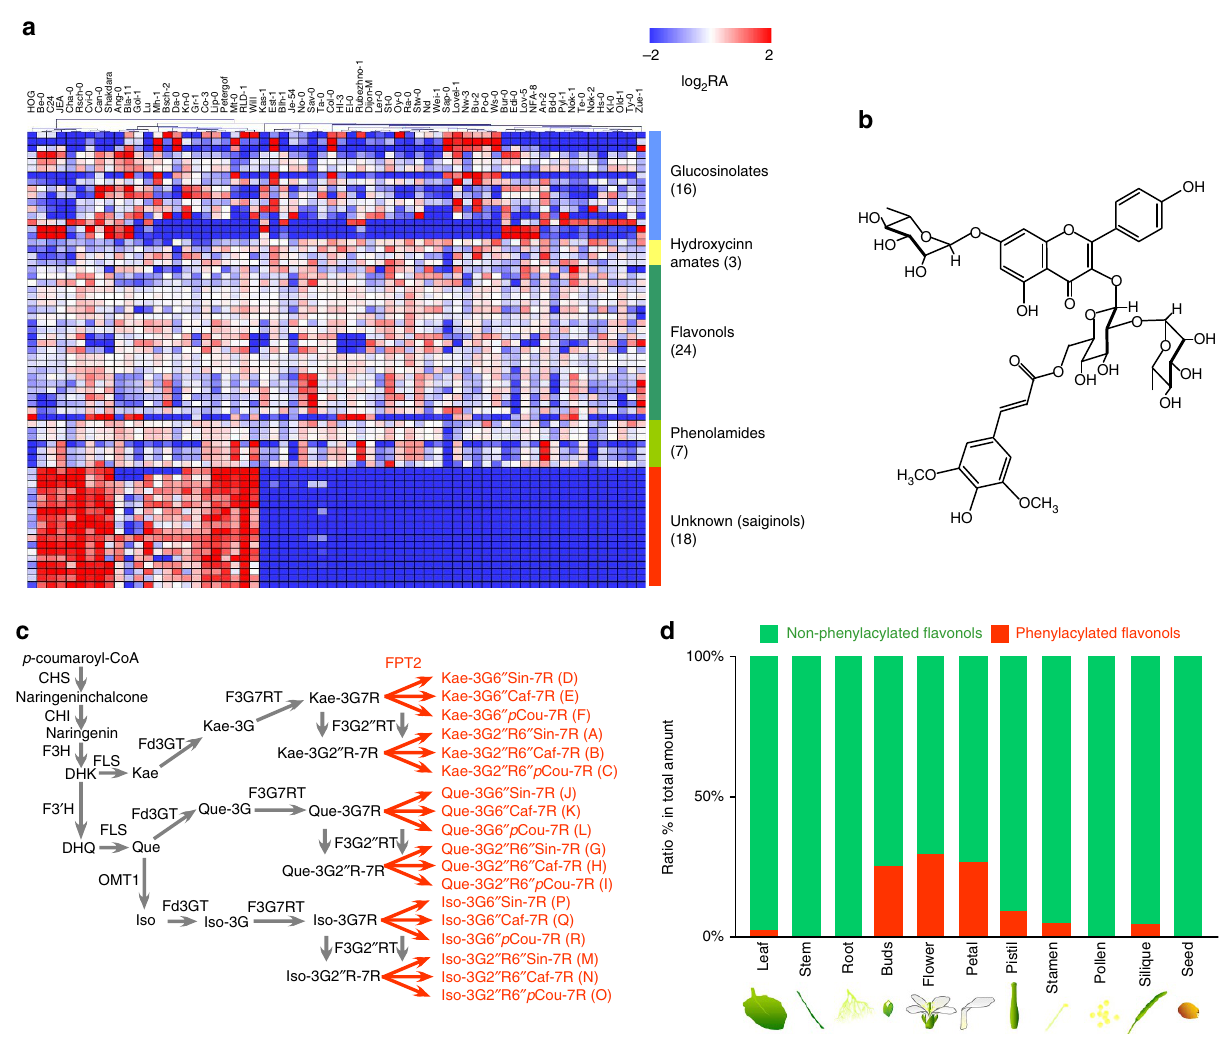
Figure 1 | Novel phenylacylated-flavonol glycosides found in A. thaliana accessions. ( a ) LC/MS profiling of secondary metabolites in Arabidopsis accession flowers. A total of 64 accessions were profiled in biological triplicate ( n ¼ 3). Heatmap shows values displayed on a log 2 relative peak area (RA) scaled by the average of all values. ( b ) Chemical structure of saiginol A isolated and characterized in this study. ( c ) Constructed novel biosynthetic branches for 18 saiginol productions in producer Arabidopsis accessions. ( d ) Tissue specificity of the accumulation of saiginols and relative ratio of phenylacylated(red)/non-phenylacylated(green) flavonols in producer C24 accession. Total phenylacylated- and non-phenylacylated-flavonol contents were compared using their abundance against total amount of all flavonols measured by LC/MS in each tissue type. Caf, caffeoyl; CHI, chalcone isomerase; CHIF3H, flavanone 3-hydroxylase; CHS, chalcone synthase; DHK, dihydrokaempferol; DHQ, dihydroquercetin; F3 0 H, flavonoid 3 0 -hydroxylase; Fd3GT, flavonoid 3- O -glycosyltransferase; F3G7RT, flavonol-7- O -rhamnosyltransferase; F3G2 00 RT, anthocyanin-3- O -glucoside-2 00 - O -rhamnosyltransferase; FLS, flavonol synthase; FPT, flavonol-phenylacyltransferase; G, glucose; Iso, isorhamnetin; Kae, kaempferol; OMT1, O -methyltransferase 1; p Cou, p -coumaroyl; Que, quercetin; R, rhamnose; Sin, sinapoyl. NATURE COMMUNICATIONS|7:12399|DOI: